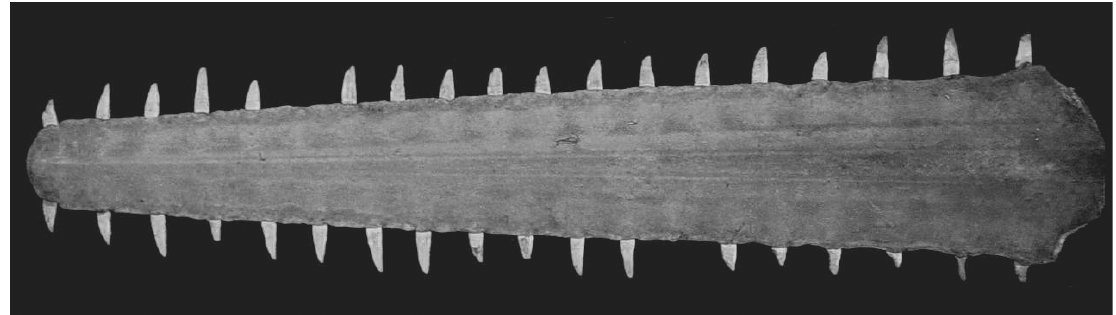
Fig. 3 . Living sawfish rostrum ( Pristis perotteti ), dorsal view, NUPEC 018, 627 mm, Brazil,